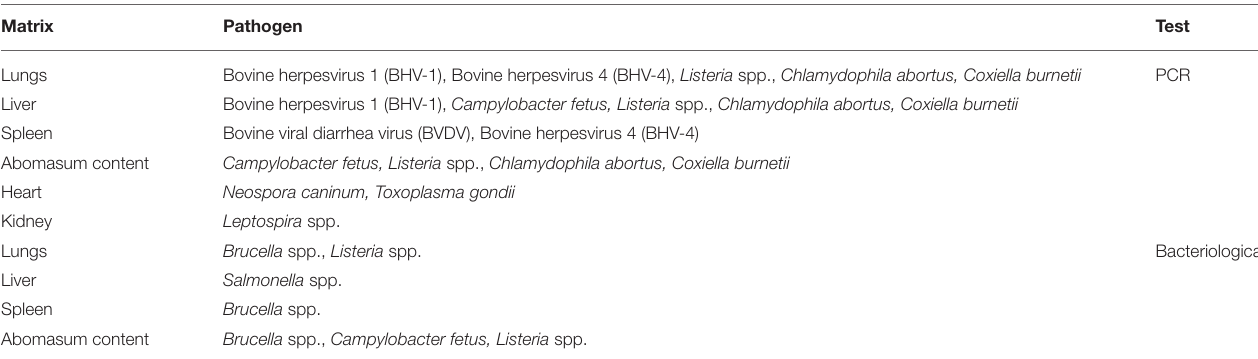
TABLE 1 | Investigated abortive agents for each tested organ. Matrix